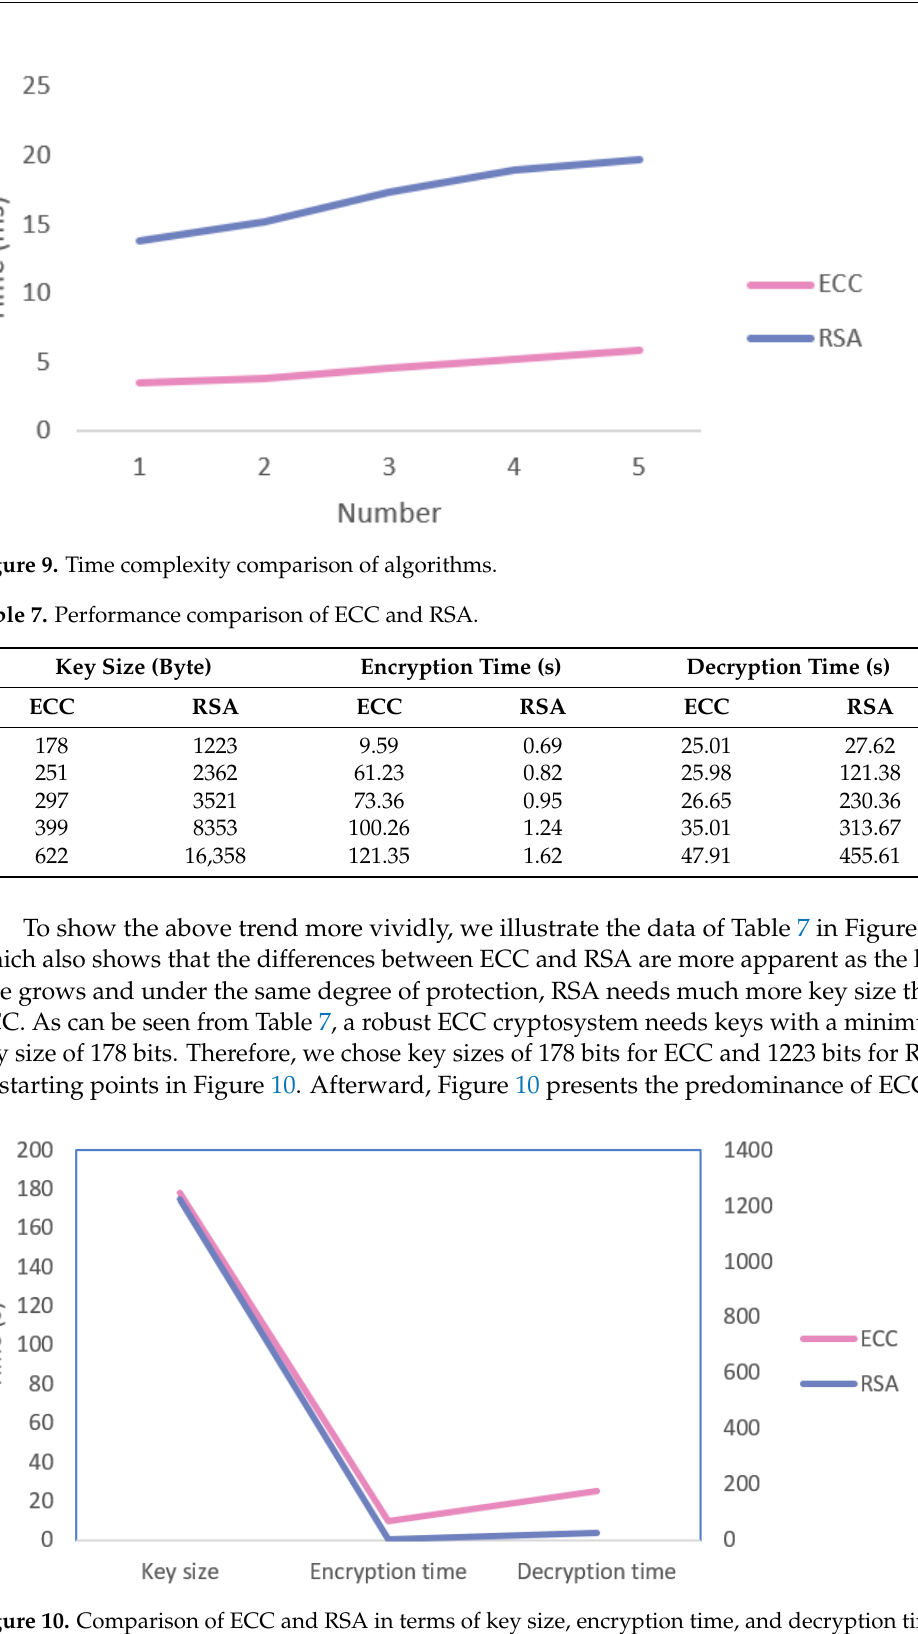
Figure 10. Comparison of ECC and RSA in terms of key size, encryption time, and decryption time.